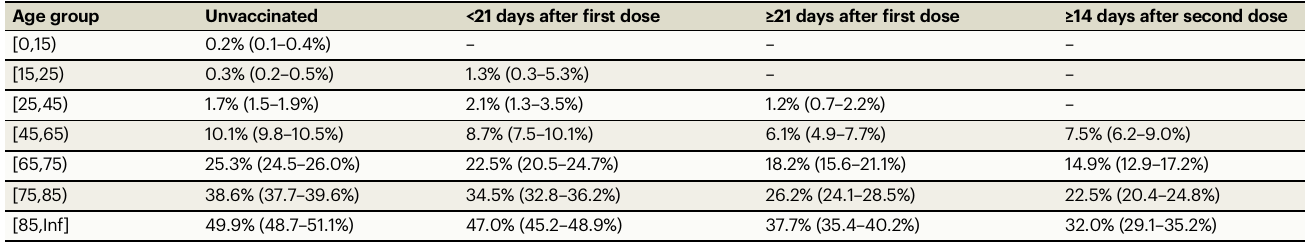
Table 2 | Hospitalised fatality risk by vaccine status at hospital admission and age group